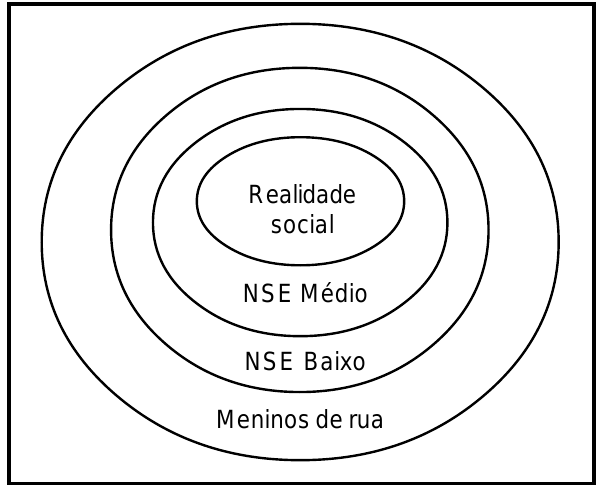
Figura 9 . Representação modular da relação entre os diferentes grupos sendo comparados através das análises